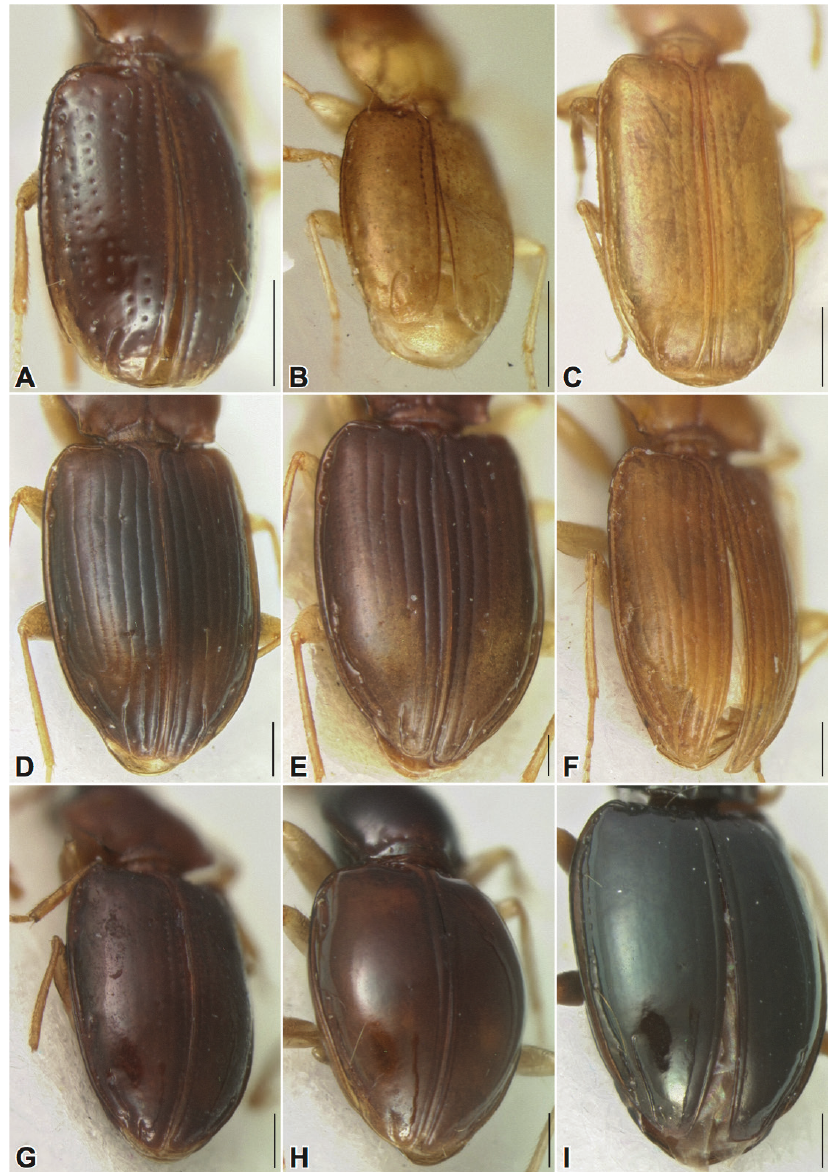
Figure 5. Elytral apex, left dorsal oblique view. A Stigmatachys uvea (holotype, ♀ ), Perú, Loreto, Cam- pamento San Jacinto B Polyderidius sp., México: San Luis Potosí C Nothoderis rufotestacea , USA: AZ: Cochise Co. D Meotachys ( Hylotachys ) ballorum (paratype, ♀ ), Brazil, Amazonas, Tapurucuara E Ela- phropus ( Ammotachys ) marchantarius (paratype, ♂ ), Venezuela, San Carlos de Rio Negro F Meotachys ( Scolistichus ) riparius (paratype, ♀ ), Brazil, Amazonas, Rio Solimões, Ilha de Marchantaria G Elaphropus ( Idiotachys ) acutifrons (paratype, ♀ ), Brazil, Santarem H Elaphropus ( Nototachys ) occidentalis (paratype, ♂ ), Perú, Madre de Dios, Pakitza I Tachyxysta howdenorum (holotype, ♂ ), México, Chiapas, El Aguacero. Scale bars = 0.25